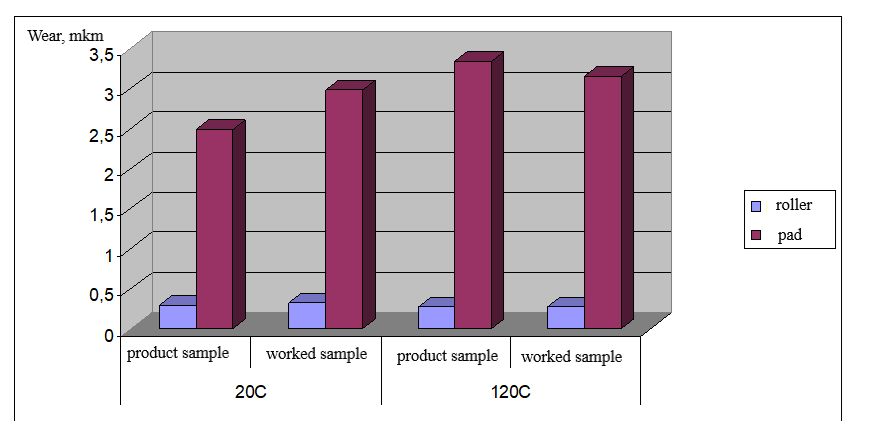
Fig. 4. Linear wear of the Cane friction surfaces (roller - shoe) at 700 operating cycles at volume temperatures of the lubricant 20 0 C and 120 0